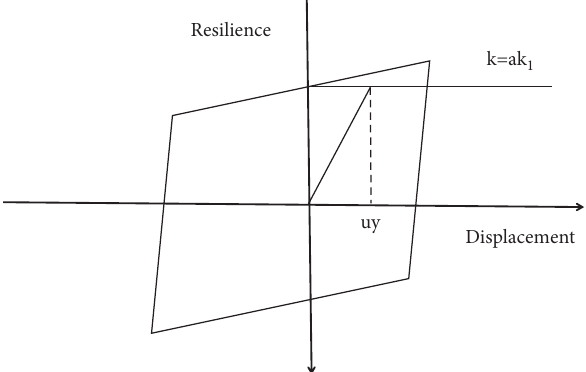
Figure 1: Displacement-restoring force curve of the bilinear